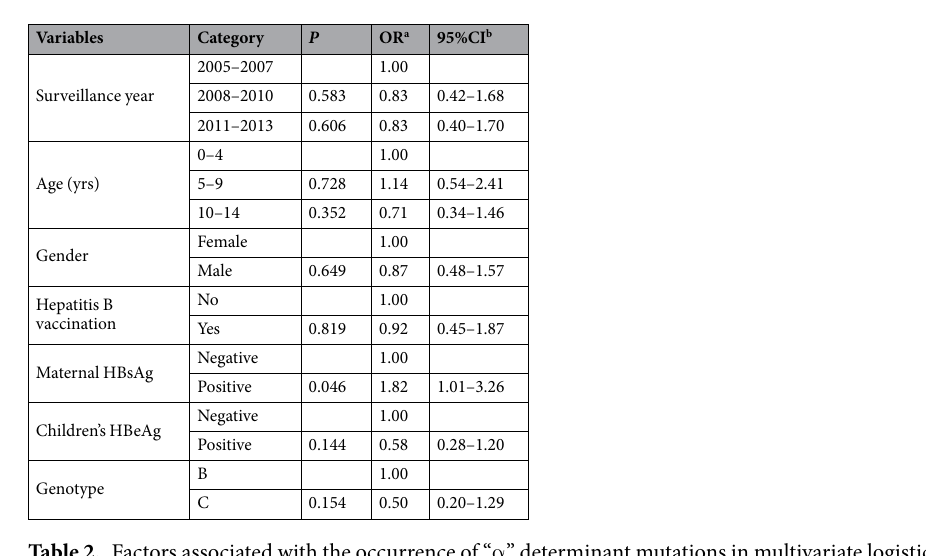
Table 2. Factors associated with the occurrence of “ α ” determinant mutations in multivariate logistic regression among hepatitis B cases aged 0–14 years. a Odds ratio (OR) and b 95% confidence interval (95% CI) for OR were calculated to assess the association between the occurrence of “ α ” determinant mutations and relevant factors. The statistical significance level of P < 0.05 was